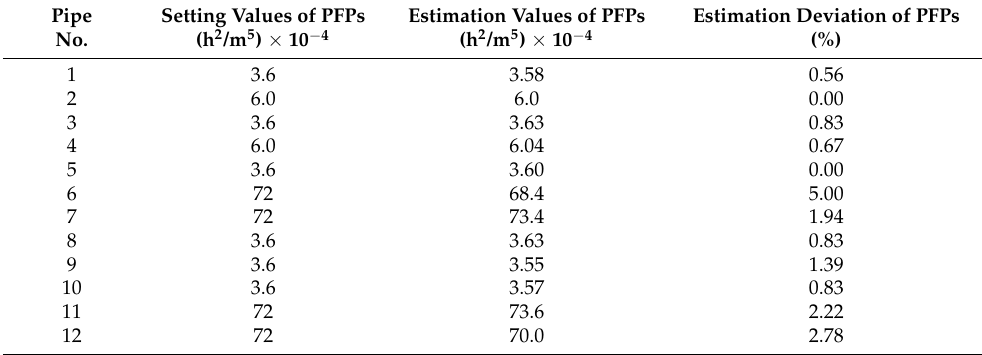
Table 1. The estimation results of the example HN.